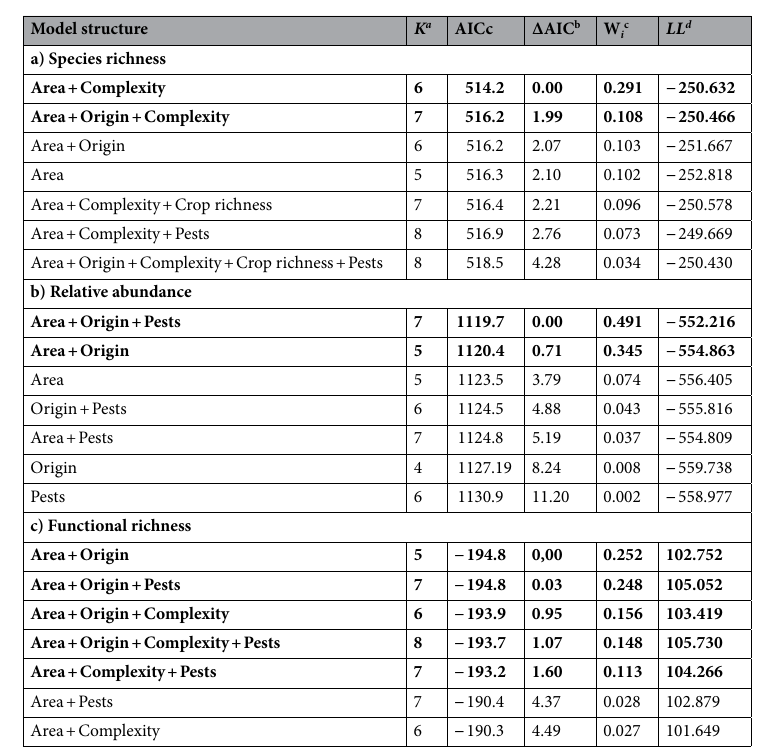
Table 1. Ranking of models for species richness, relative abundance, and functional richness as a function of social-ecological filters. Season and locality were random terms in all tested models. Model structure in bold indicates the best models with equivalent support. a Number of parameters estimated; b Difference in AICc values between each model and the lowest AICc model; c AICc model weight; d Log